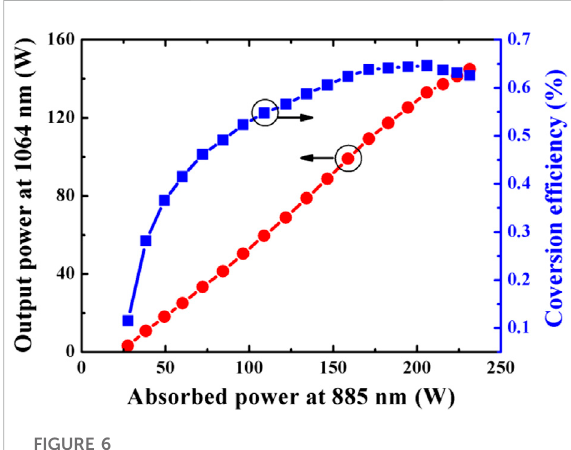
FIGURE 6 Output power of the 1,064-nm laser versus absorbed power at 885